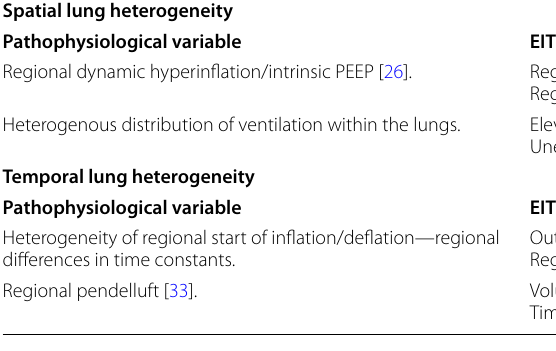
Driving pressure (cmH 2 O)